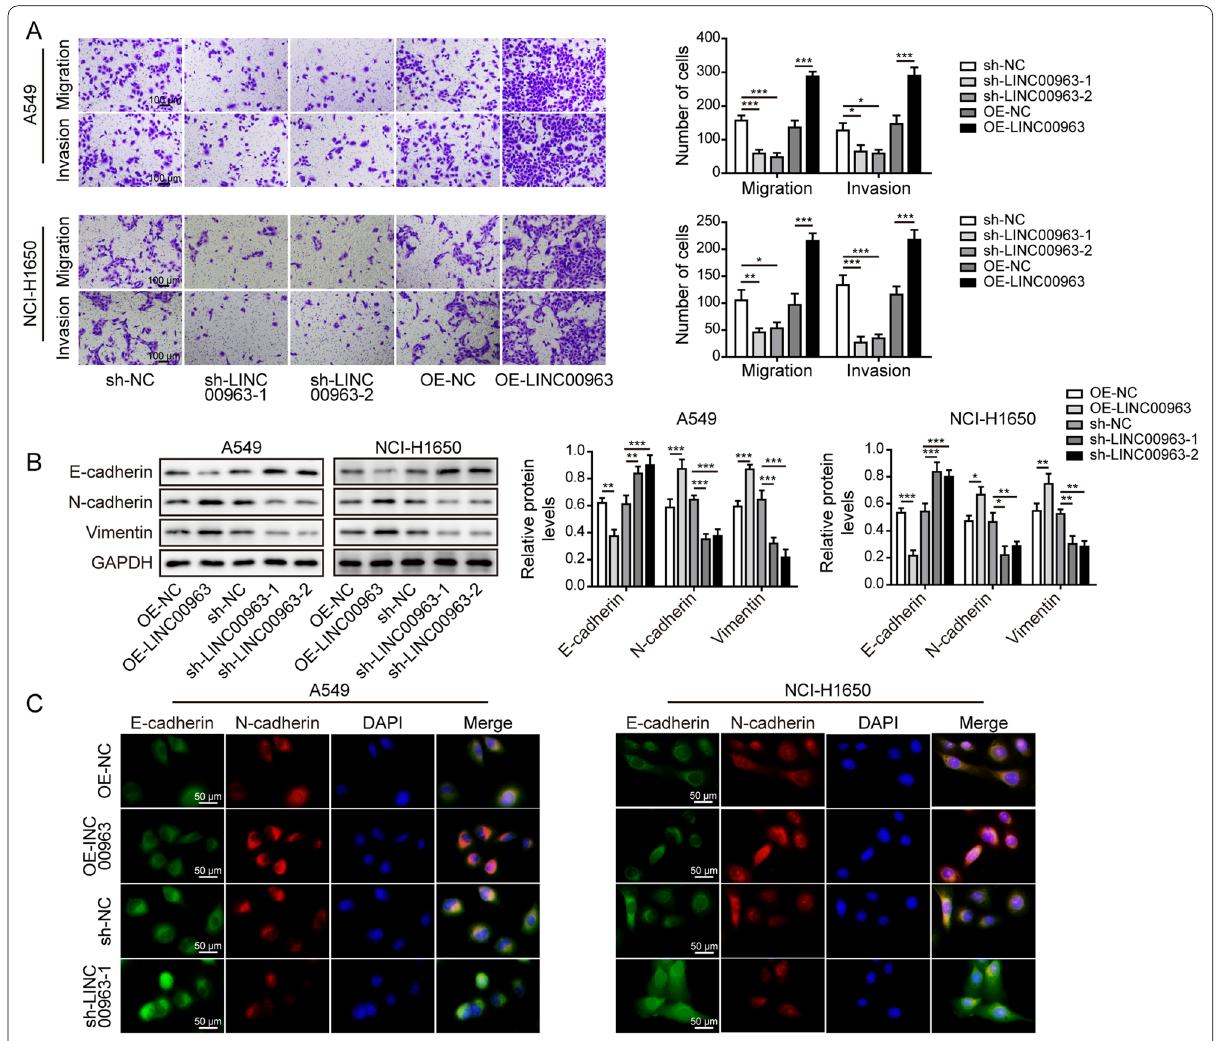
Fig. 3 LINC00963 significantly induced the migration, invasion, and EMT of LUAD cells. A549 and NCI-H1650 cells stably expressed two distinct shRNA targeting LINC00963 or overexpressed LINC00963. A Cell migration and invasion were assessed by Transwell assays. B Expression levels of E-cadherin, N-cadherin, and vimentin were examined by western blot. C E-cadherin (green) and N-cadherin (red) were detected by immunofluorescence and the nuclei were stained by DAPI (blue) in indicated cells. Scale bar: 50 μm. * P < 0.05, ** P < 0.01 and *** P <